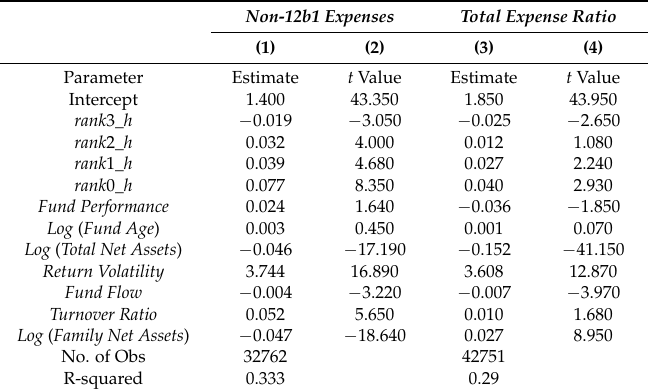
Table 4. Impact of competition on other